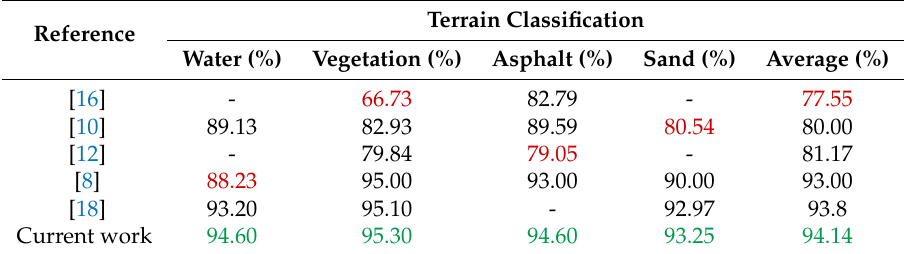
Table 3. Comparison between existing Terrain Classification Systems—Sorted by success